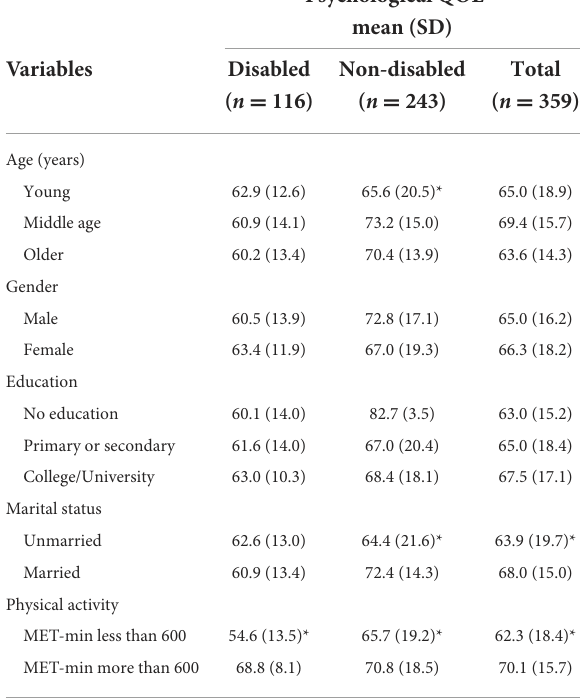
TABLE 3 Psychological QOL by demographic characteristics and physical activity level among disabled and non-disabled (Bivariate analysis).